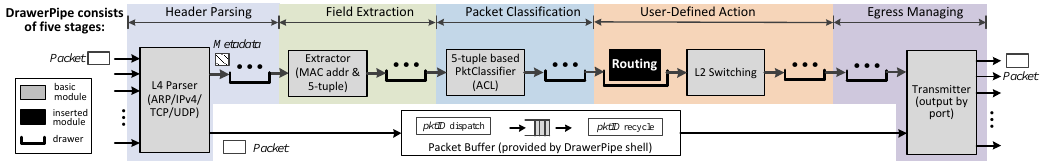
Figure 5. Extending L3 routing function by adding a Routing module (black) in the five-stage